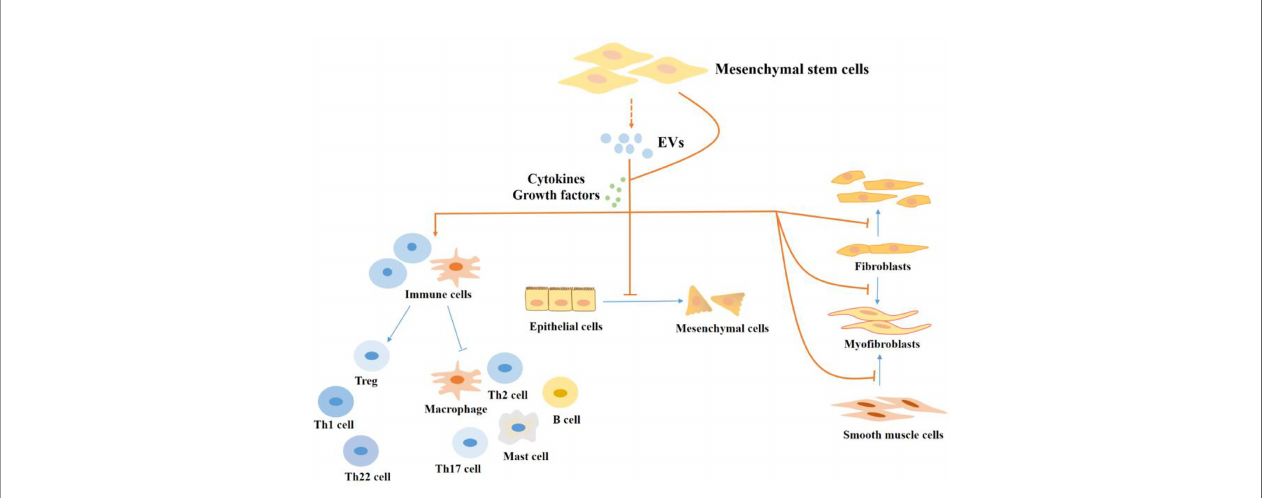
FIGURE 3 | The regulatory effect of MSCs in the progression of fi brosis in IBD. MSCs regulate intestinal fi brosis. MSCs regulate cells in the process of fi brosis by producing cytokines and growth factors or by secreting EVs. MSCs inhibit the proliferation and activation of pro- fi brotic immune cells, like Th17 cells, Th2 cells, M1 macrophages, and mast cells, and promote the production of M2 macrophages and Tregs which inhibit fi brosis. In addition, MSCs inhibit the EMT process and the production of myo fi broblasts. EVs, extracellular vesicles; Th, T helper; Treg, Regulatory